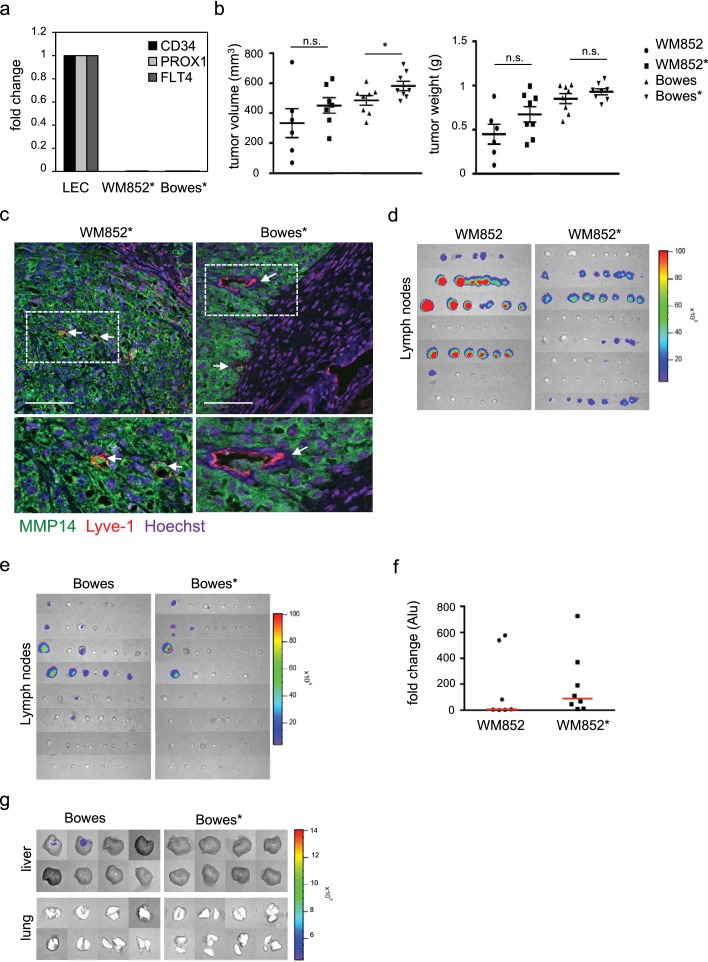
Analysis of mouse xenografts and distant organ metastasis.(a) mRNA expression of a panel of LEC markers (CD34, PROX1, FLT4) in 3D LEC primed Bowes and WM852 cells (*) before the cells were used for the in vivo xenograft assay. Expression in monotypic-cultured LEC was used as a control and set to one. (b) End point analysis of the volume (left panel) and weight (right panel) of the Bowes/Bowes* and WM852/WM852* tumors. A dot represents one mouse. Error bars indicate s.e.m. *: p<0.05. n.s., non-significant (c) Immunohistochemistry of xenograft sections from the LEC co-cultured WM852* (left panels) or Bowes* (right panels) stained for mouse Lyve-1 (red) to detect mouse lymphatic vessels and human MMP14 (green) as a marker of the human melanoma cells. Nuclei were counterstained with Hoechst 33342. Scale bar = 100 µm. (d, e) Luciferase signal from lymph nodes isolated from mice bearing WM852 (n = 7) and WM852*(n = 8) (d), or Bowes and Bowes* (n = 8) (e); each line shows lymph nodes from one mouse derived tumors. (f) Quantitative-PCR (q-PCR) for human Alu sequences from lung genomic DNA isolated from mice bearing WM852 and WM852* derived tumors. Each dot in the graph represents the luciferase signal intensity obtained from one isolated organ per mouse, and the red line marks the median of the samples. (g) Luciferase signal from liver and lungs isolated from mice bearing Bowes or Bowes* derived tumors (n = 8); each box represents an organ from one mouse.